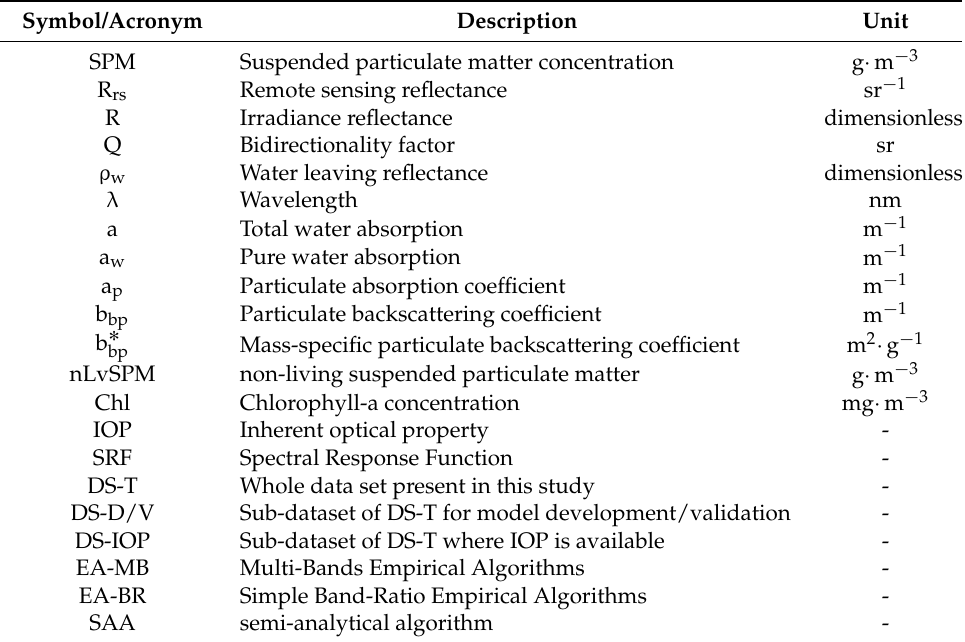
Table 1. List of symbols and